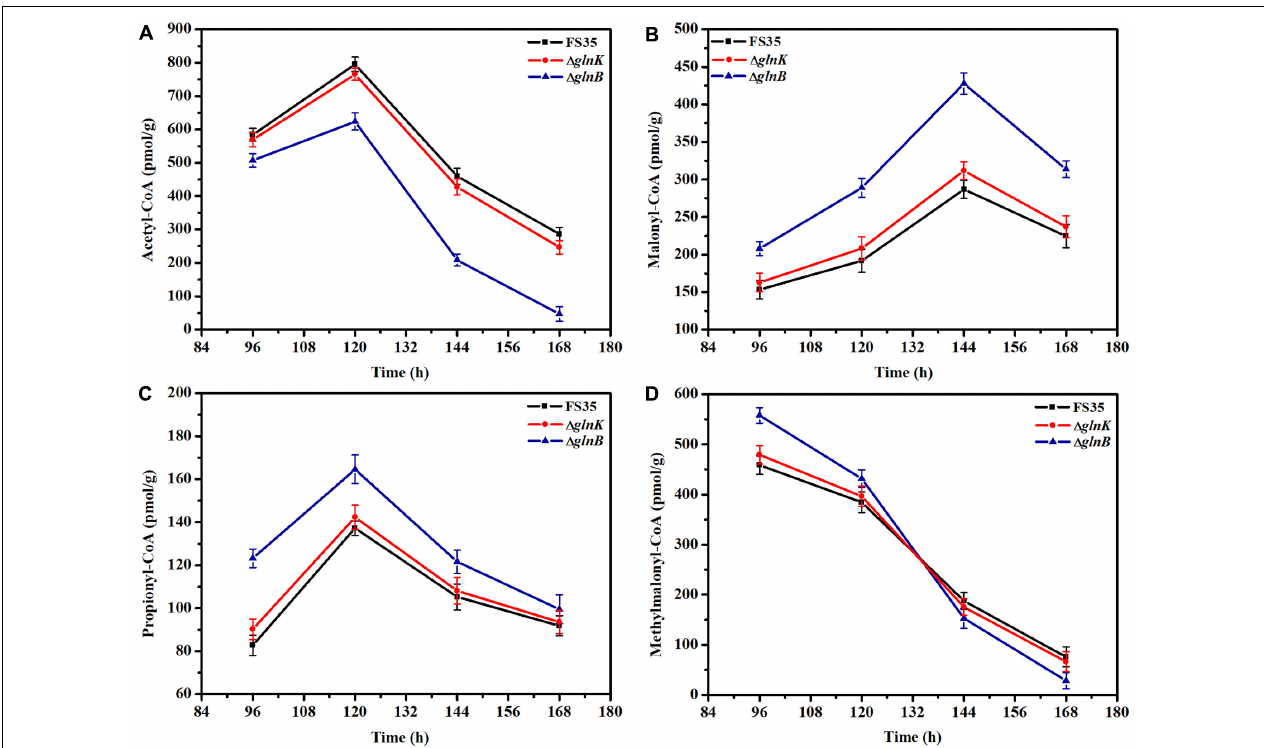
FIGURE 4 | Changes in the intracellular concentrations of coenzyme A esters induced by the deletion of PII proteins. (A) Changes of intracellular acetyl-CoA concentration caused by the deletion of GlnB or GlnK. (B) Changes of intracellular malonyl-CoA concentration induced by the removal of GlnB or GlnK. (C) Changes of intracellular propionyl-CoA concentration caused by the deletion of GlnB or GlnK. (D) Changes of intracellular methylmalonyl-CoA concentration induced by the removal of GlnB or GlnK. The concentrations of coenzyme A esters in the parent strain FS35 were used as reference for comparison. The (cid:49) glnB represents the glnB deletion strain based on the parent strain FS35. The (cid:49) glnK represents the glnK deletion strain based on the parent strain FS35. All data represent the mean values of three independent technical replicates, and the error bars represent the standard deviations.